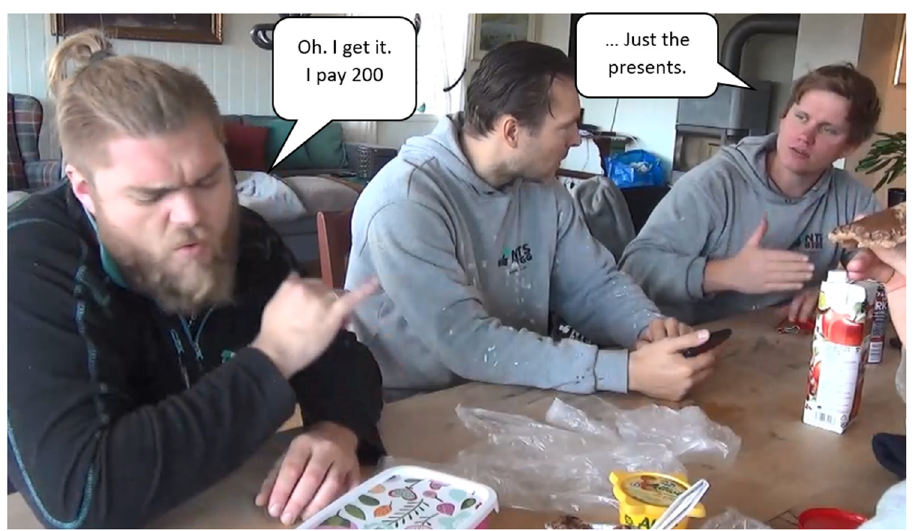
Figure 12: Abe ( left ) displaying understanding. ( Line 13. Carl retracting his hands from the sign “ PRESENT ” from line 12.